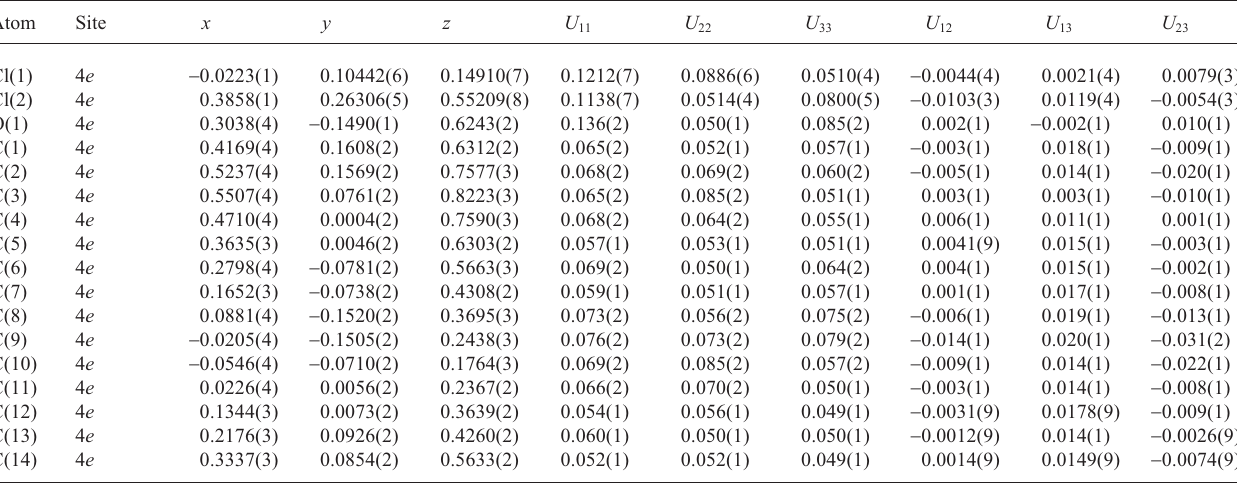
Table 3. Atomic coordinates and displacement parameters (in Å 2 )